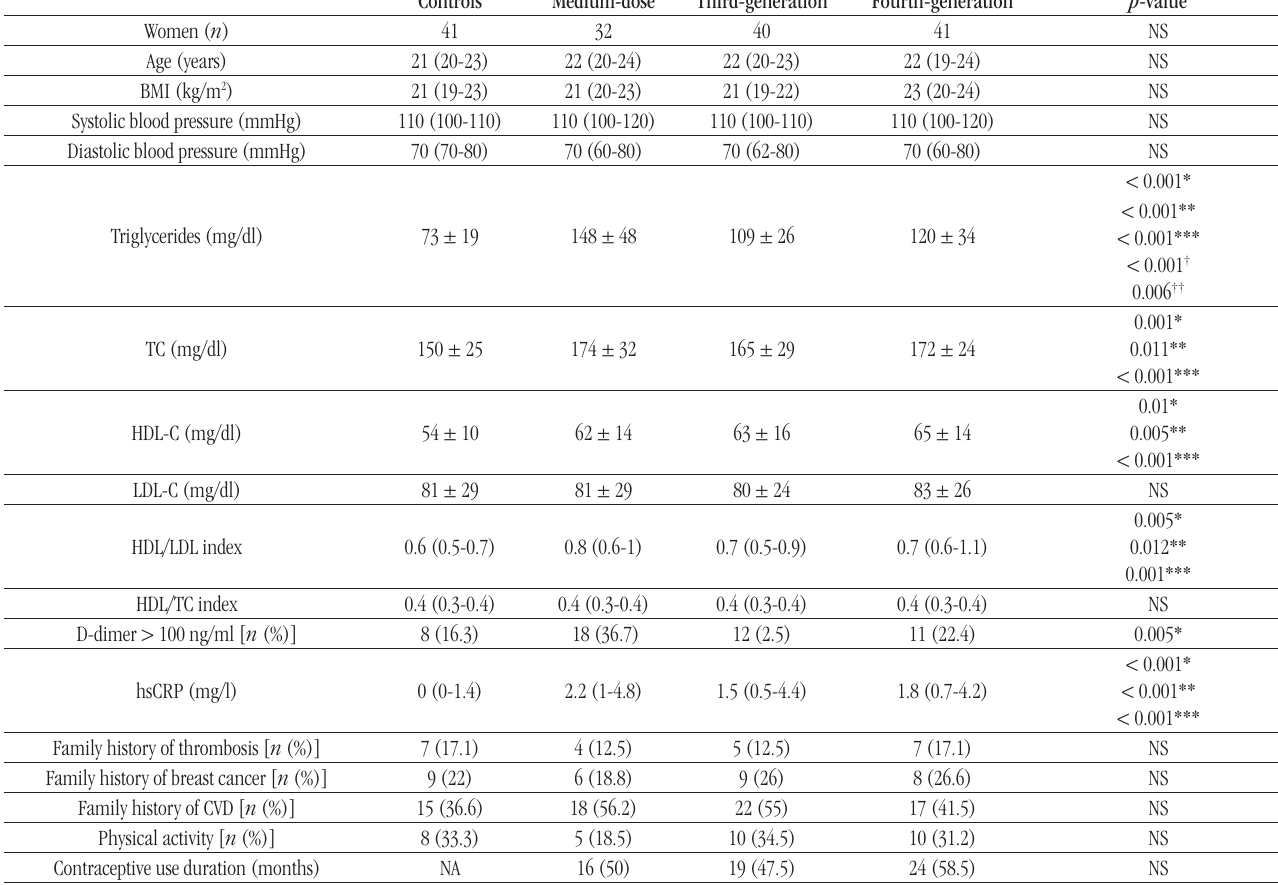
taBLE − Clinical and laboratory characteristics of users and nonusers of oral contraceptives Controls Medium-dose